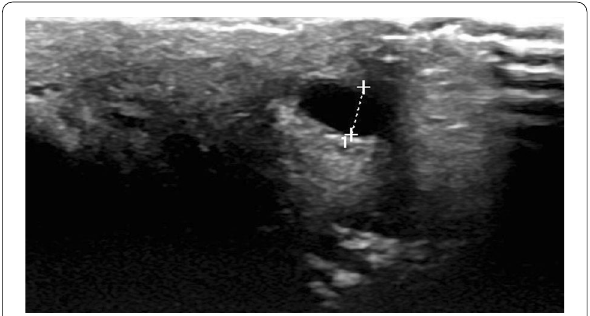
Fig. 1 Ultrasonographic view of incompressible dilated superficial venous structure on dorsum of